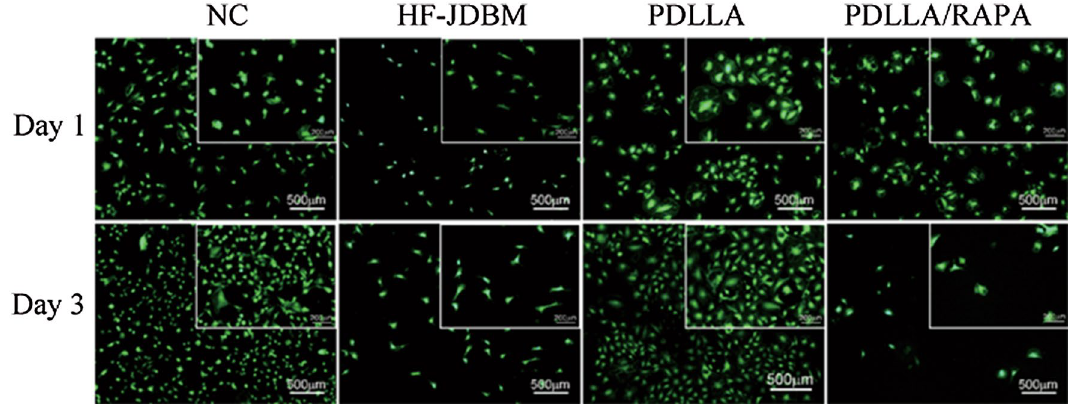
Figure 1. The adhesion morphologies of A7r5 cells on HF-JDBM, PDLLA coated JDBM, PDLLA/RAPA coated JDBM, and negative control (NC) for 1 and 3 days (Stained with Calcein-AM, and green signals represent live